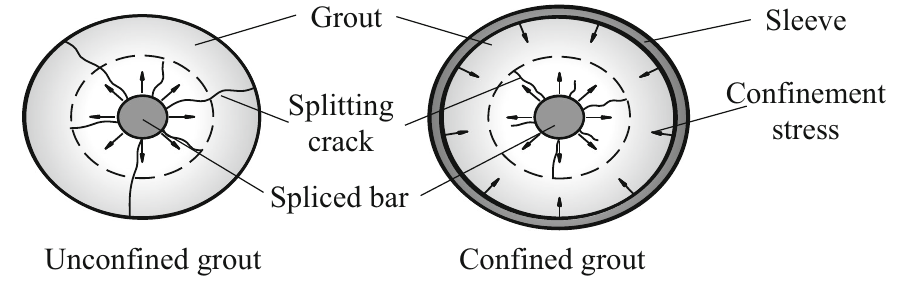
Fig. 2 Sleeve confines the grout and control the propagation of splitting cracks.